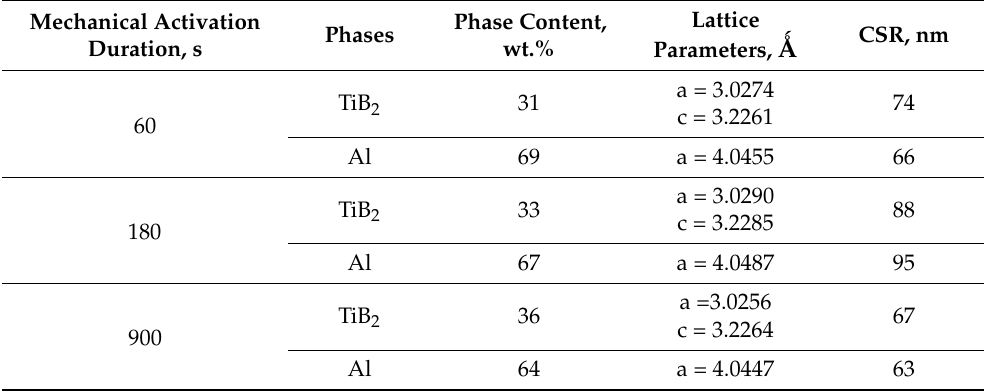
Figure 5. XRD patterns of the SHS products obtained from the Al-Ti-B powder mixture after ( a ) 60 s, ( b ) 180 s, and ( c ) 900 s of mechanical activation. Table 1. XRD results of the SHS Table 1. XRD results of the SHS products.